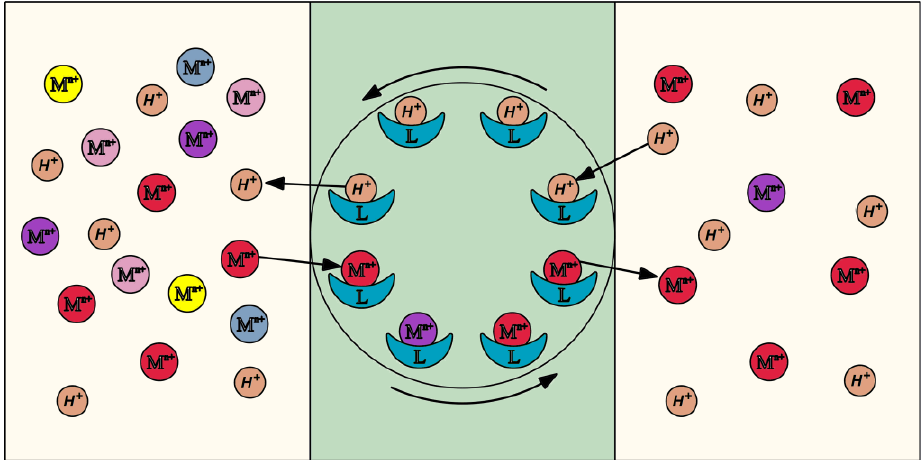
Figure 8. Transport of metal ions through the membrane: a layout.